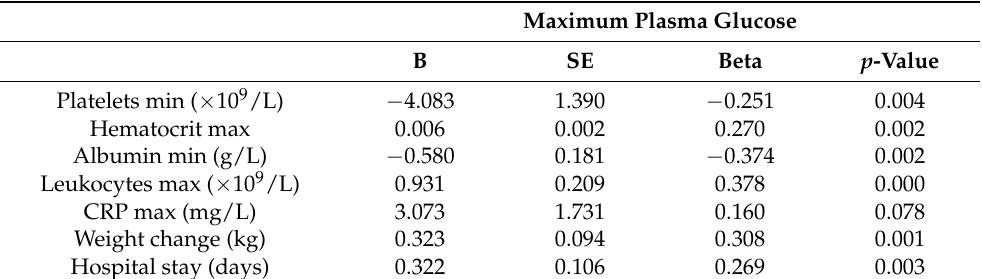
Table 4. Multivariate linear regression analysis for disease severity outcomes, dependent of maximum plasma glucose concentration.